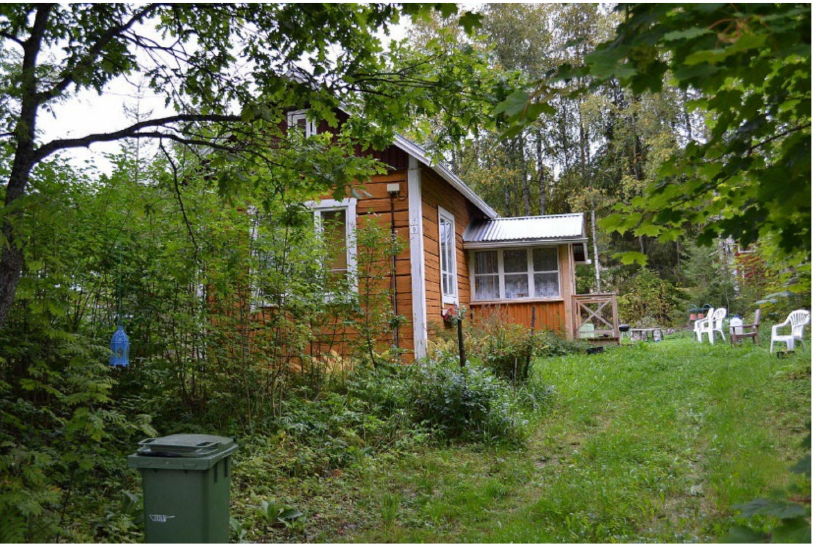
Figure 2. A small, detached house surrounded by a green yard in Haapamäki, Finland (Source: